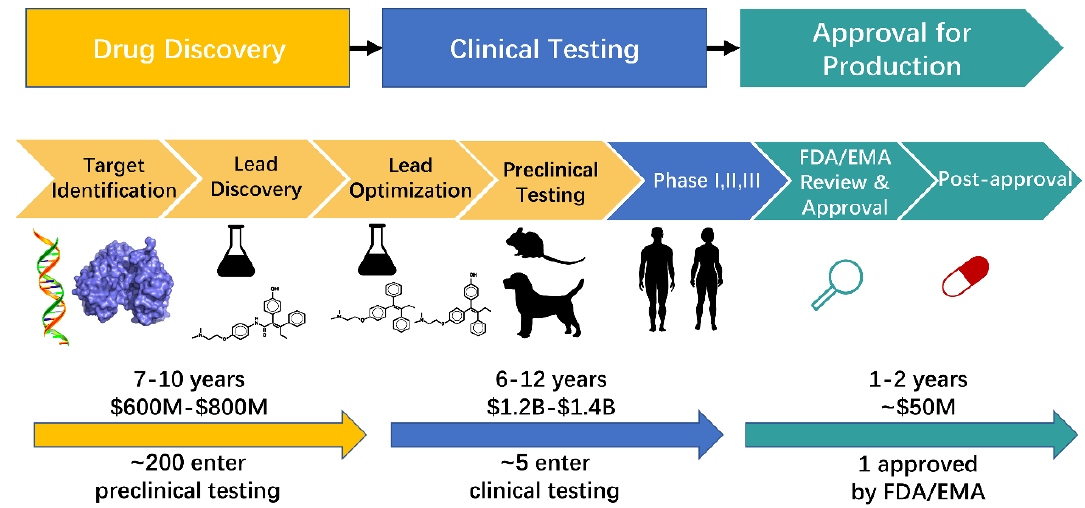
Figure 1. The process of drug research and development. The details in drug development have been improved in the past forty years. Nowadays, the complete process in drug research includes drug discovery, clinical testing, and approval for production. The process of drug discovery includes target identification, lead discovery, lead optimization, and preclinical testing. This process usually takes 7 – 10 years and $600 M – $800 M. Then approximately 200 compounds enter preclinical testing step while about 5 compounds enter clinical testing process. This process includes three steps, phase I, II and III clinical trials, respectively. It is a long and expensive process that costs 6 – 12 years and billions of dollars. The compounds that have passed clinical testing enter the process of approval for production. Approved compounds by FDA/EMA can commercialize on the market. This process takes 1 – 2 years and about $50 M.